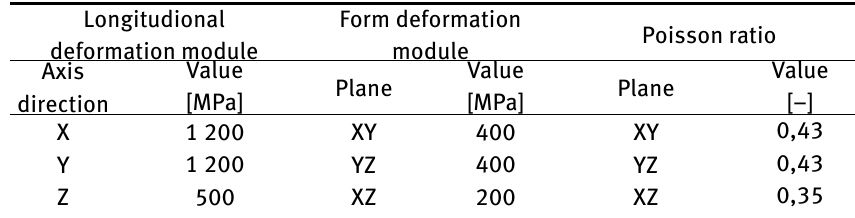
Table 2: Mechanical properties of the polyamide fiber of 1 mm thickness [14]